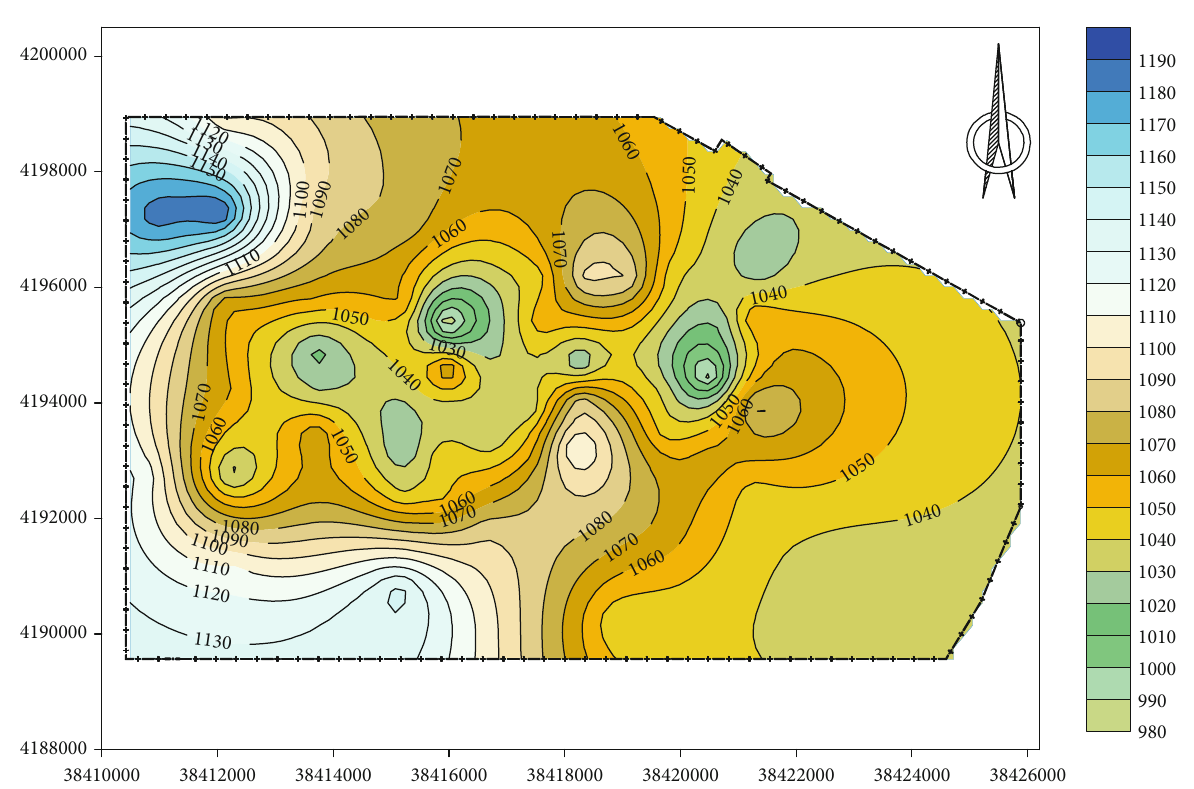
Figure 3: Thematic map of buried depth of the K